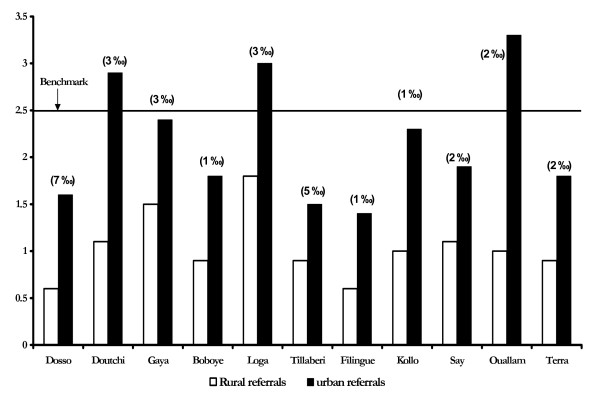
Observed rural and urban referral rates compared to the ”strict guidelines application„ benchmark. Figures in brackets represent population-based yearly hospitalisation rates in the district.